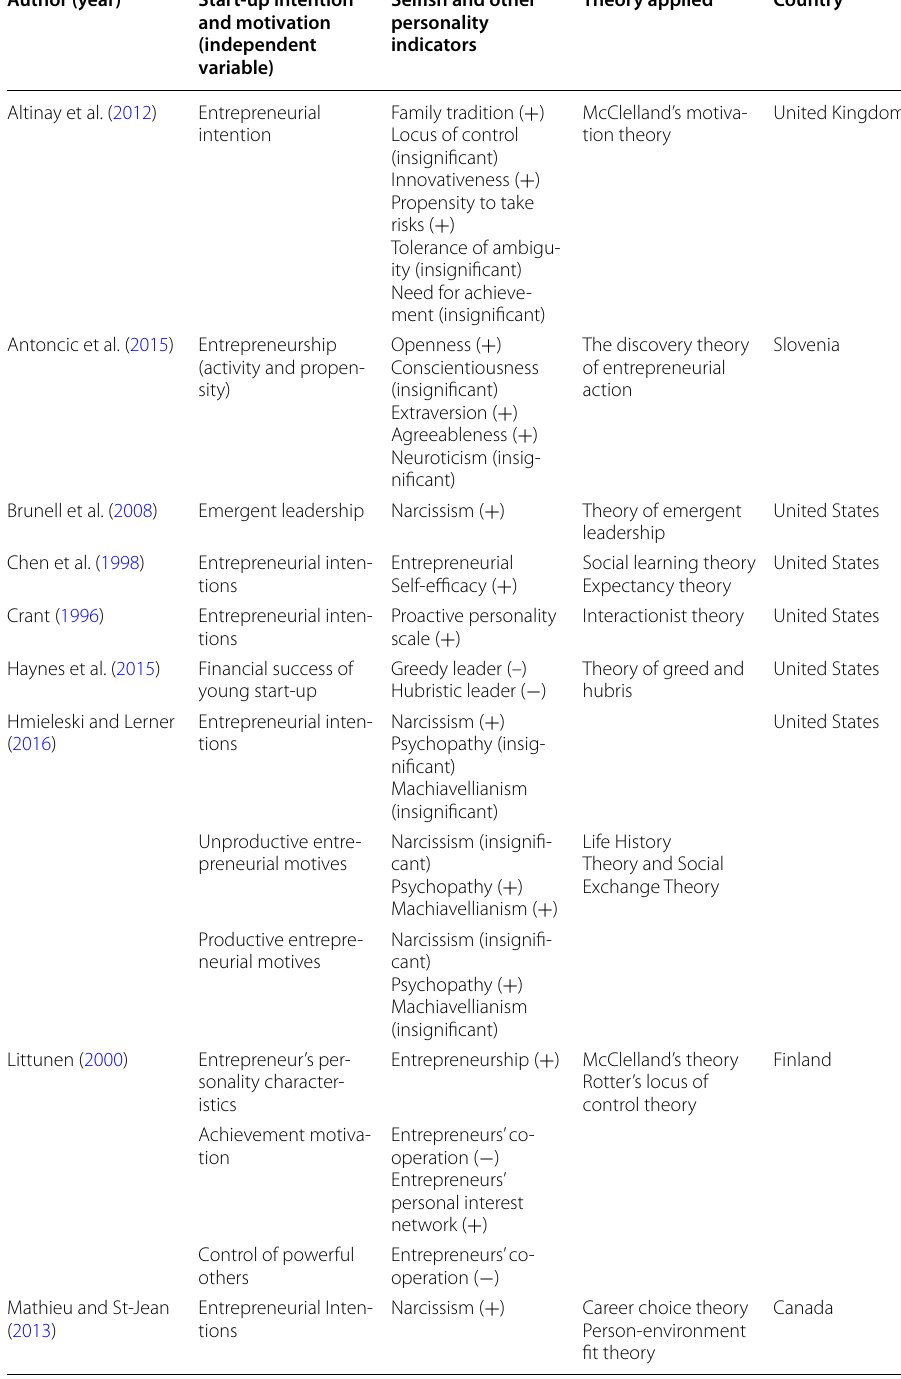
Table 1 Overview of previous studies Author (year)